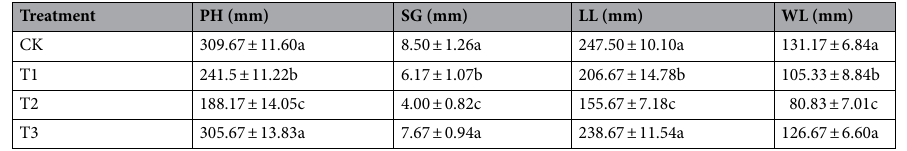
Table 4. The effects of different treatments on agronomic traits of tobacco. * T1, the CK group inoculating R. solanacearum 1–1; T2, the T1 group adding mixed PAs; T3, the T2 group adding combined PAs-degrading bacteria; PH, plant height; SG, stem girth; LL, length of the largest leaf; WL, width of the largest leaf. Different letters indicate significant difference ( P < 0.05) according to Duncan’s multiple range test.